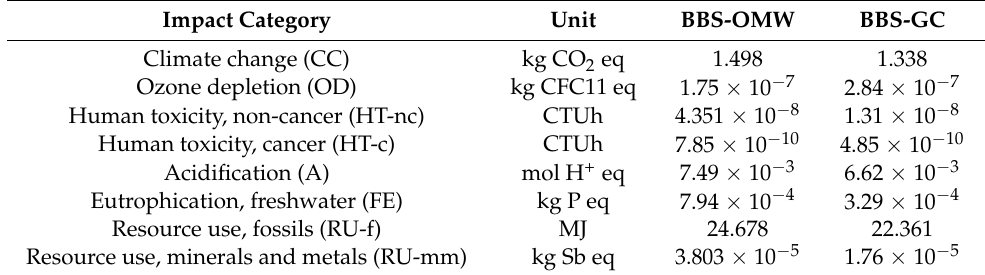
Table 7. Impact at midpoint level for the production process of 1 kg of BBS.